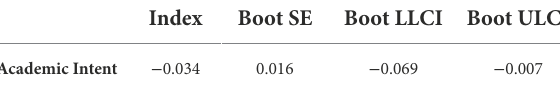
TABLE 8 Index of moderated mediation